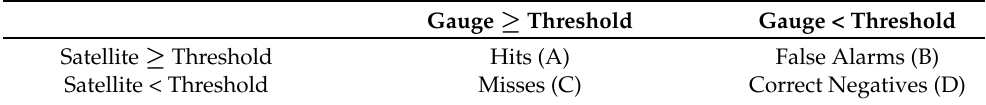
Table 3. Contingency table considering the P99th threshold by grid point.